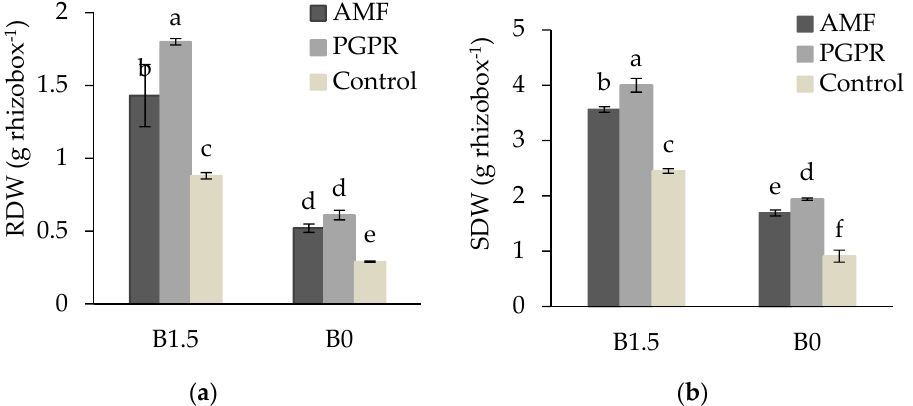
Figure 4. The effect of the organic source and microbial inoculation on RDW ( a ) and SDW ( b ). B1.5 and B0 are biochar 1.5% and no biochar, respectively. Different letters indicate significantly different values at p ≤ 0.05.